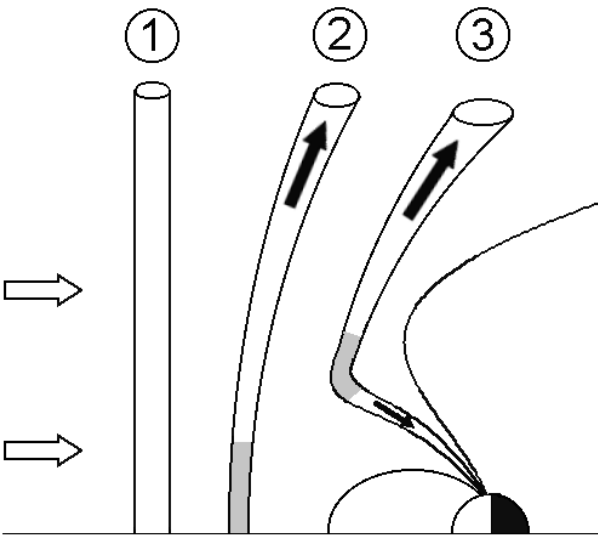
Fig. 10. Model of magnetosheath-originated EMIC waves (black arrows) penetration into the polar ionosphere. Tube 1 is the undis- turbed magnetic flux tube in the solar wind. Tube 2 is the flux tube in the magnetic barrier (plasma depletion layer). Tube 3 is the re- connected flux tube. Anisotropic plasma cloud is shown in